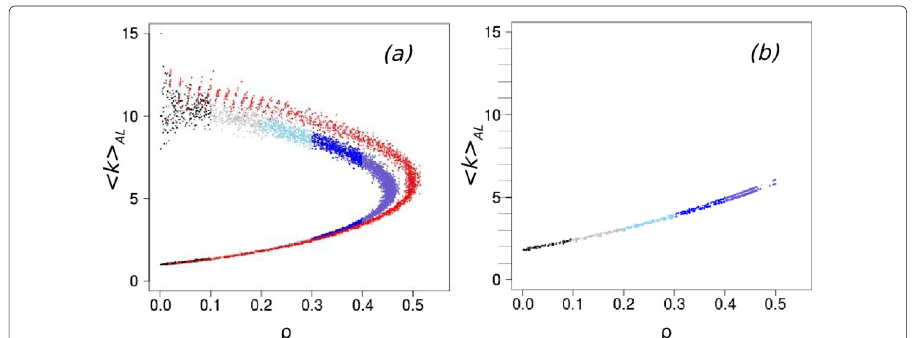
Fig. 3 Degree and degree correlations between the Erdos-Renyi contact network of < k > = 12 and the G AL for N = 1000 agents and 100 realizations of the dynamics. Panel a : mean degree of the G AL from each state’s population vs ρ . Each step of realization contributes with two points to the plot: one for the mean degree of the population of agents in state 1 and one for agents in state − 1. Different colors are used to identify different ranges of values of ρ . Red points correspond to the case in which the states of the agents are is determined from this random assignation. Panel b : mean degree of the assigned at random and the G r AL G AL vs ρ without separating